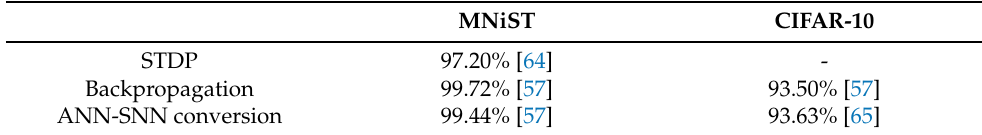
Table 1. Highest accuracy on MNiST per